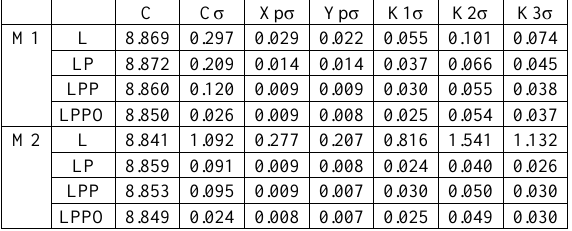
Table 6. Sigma statistics for aerial missions two and three. M2 – Proposed A, M3 – Proposed